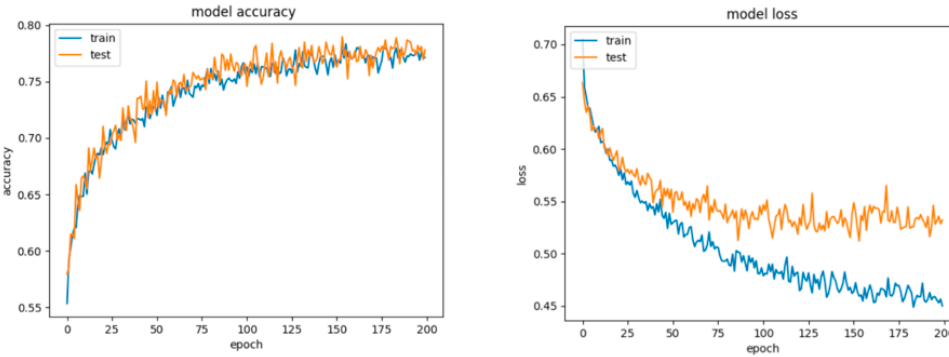
Figure 24. Accuracy and loss for Configuration 2, overlapping dataset.